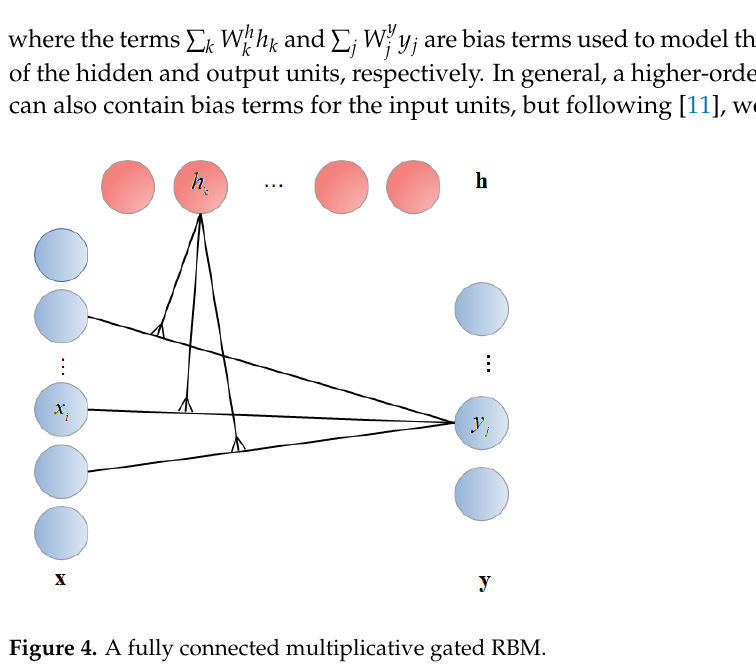
Figure 4. A fully connected multiplicative gated